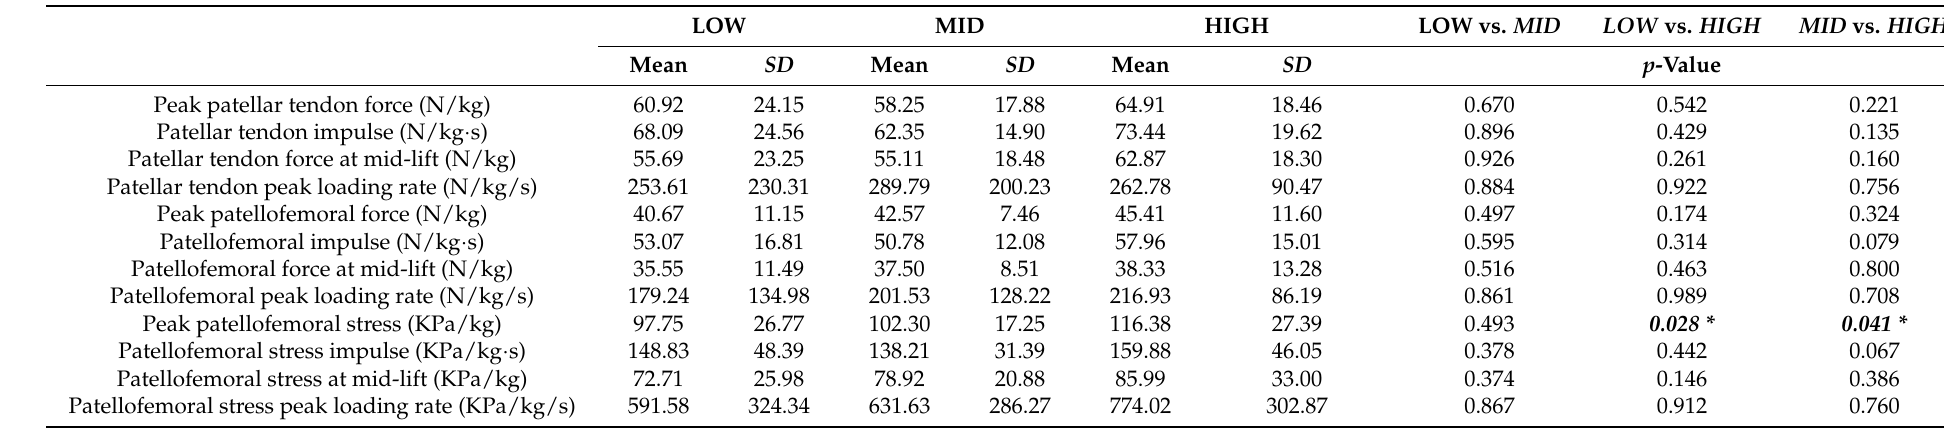
Table 4. Knee forces (mean ± SD) and statistical comparisons as a function of each experimental group. LOW MID HIGH LOW vs. MID LOW vs.